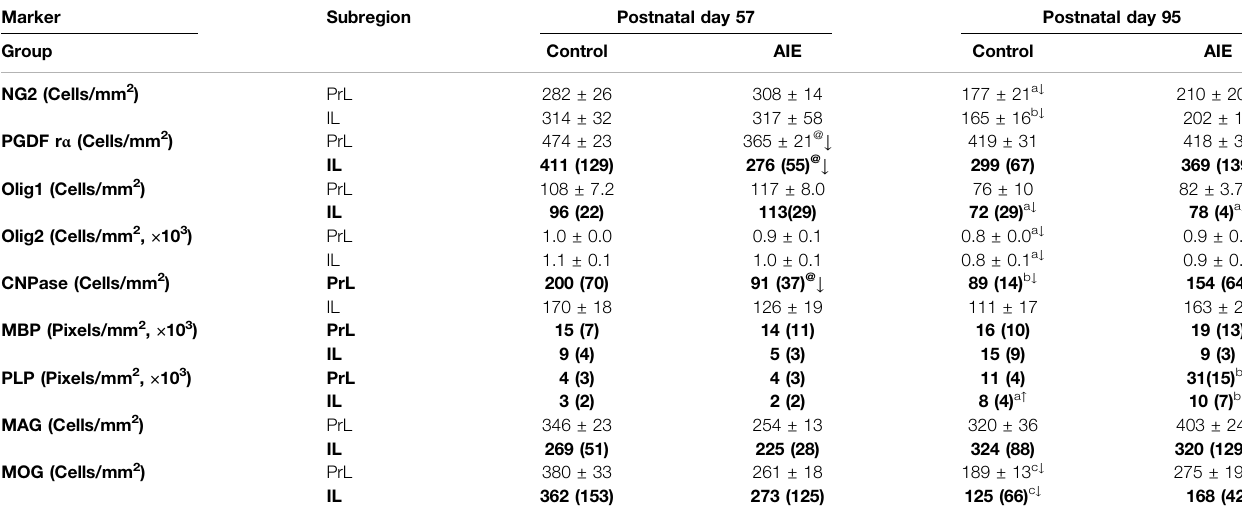
TABLE 2 | Effects of adolescent intermittent ethanol (AIE, 5 g/kg, i.g., 2 days on/2 days off) exposure on oligodendrogenesis markers in the frontal cortical gray matter, prelimbic (PrL) and infralimbic (IL) cortex of male rat brain at P57 and P95.